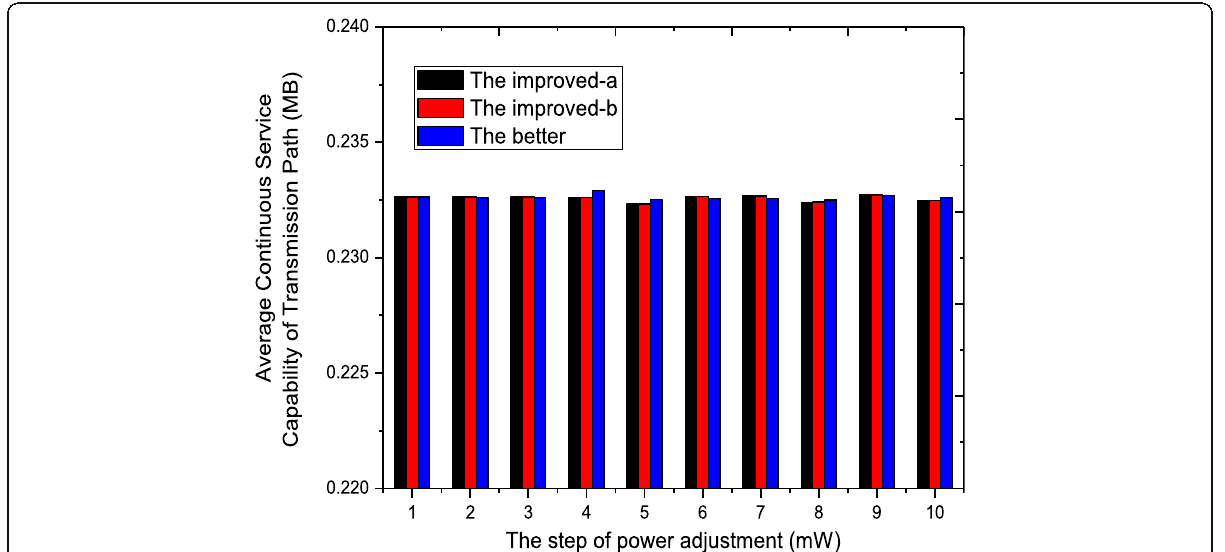
Fig. 16 Comparison of continuous service capacity: variation trend of continuous service capacity of TOM-PAOD with the step size for power adjustment, in which the different game decision algorithms are adopted